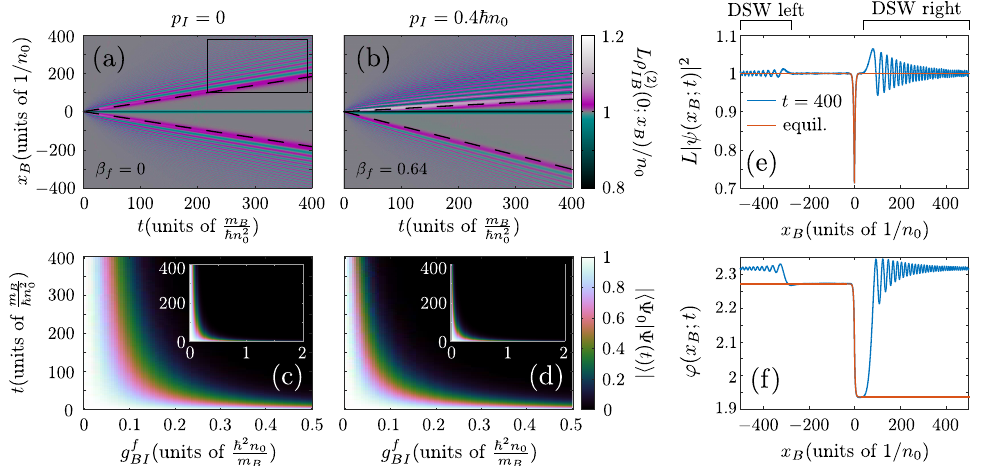
Figure 4. Quench dynamics of an impurity in a homogeneous Bose gas. ( a , b ) Spatiotemporal evolution of the two-body interspecies correlations, ρ p I (see column labels). Here the postquench interaction is g f indicate x B = ( ± 1 − β f ) ct , with β f the final velocity of the generated polaron provided as an inset label. ( c , d ) The time-dependent overlap, |(cid:104) Ψ 0 | Ψ ( t ) (cid:105)| , of the post-quench many-body wavefunction, Equation (3), with the initial state, for varying g BI . The insets of ( c , d ) provide the time-evolution of |(cid:104) Ψ 0 | Ψ ( t ) (cid:105)| within a more extensive g BI range. ( e , f ) present the modulus and phase of the GA bath-wavefunction, ψ ( x B ; t ) respectively for g f comparison ( e , f ) also provide the equilibrium profile of the polaron, Equation (7), with β = β f =